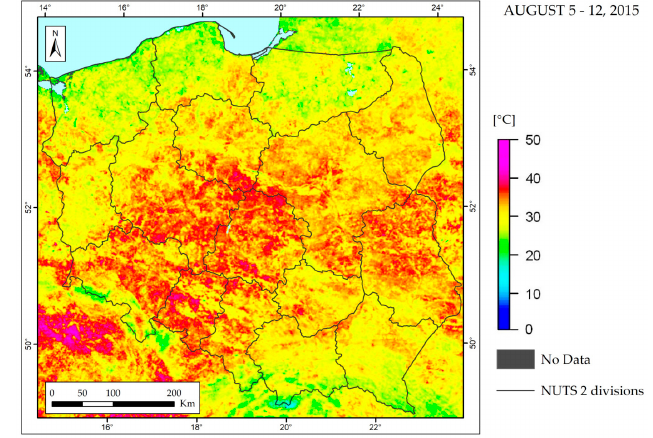
Figure 8. Temperature condition index (TCI) image, day of year (DOY) 241, 2015.